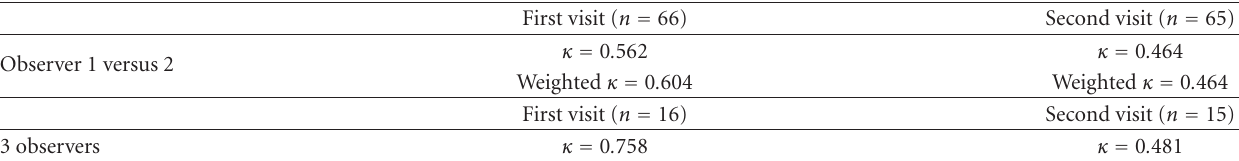
Table 3: Interobserver agreement for the TIS (categorized into mild, moderate, or